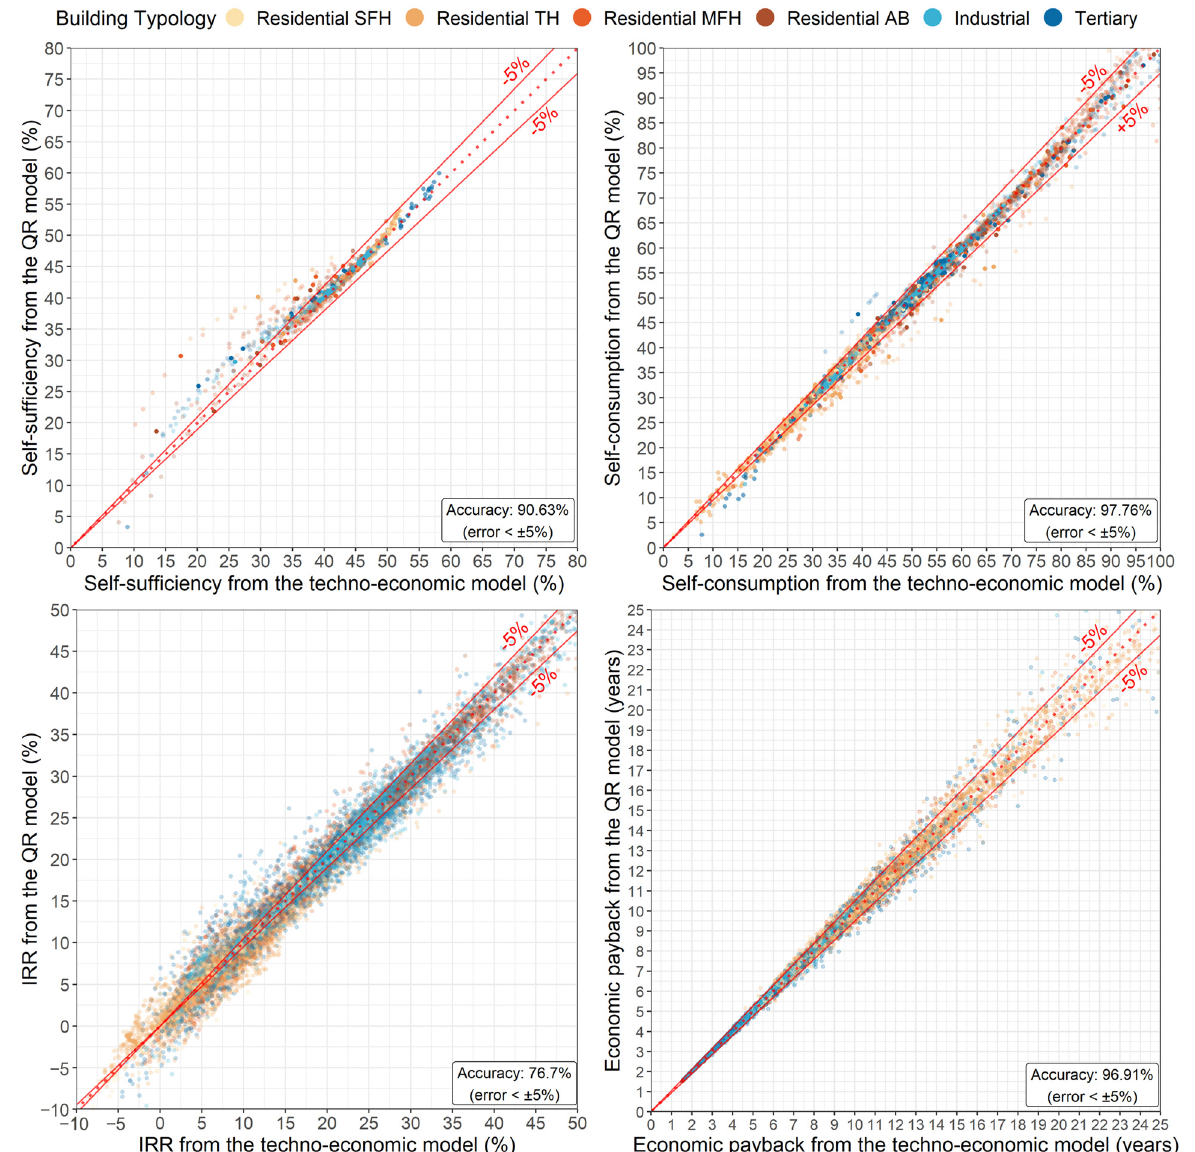
Figure 14. Validation of the predicted values SS , SC , IRR and PB by the QR models. Table 9. Error metrics of the predicted SS , SC , IRR and PB by the QR models.